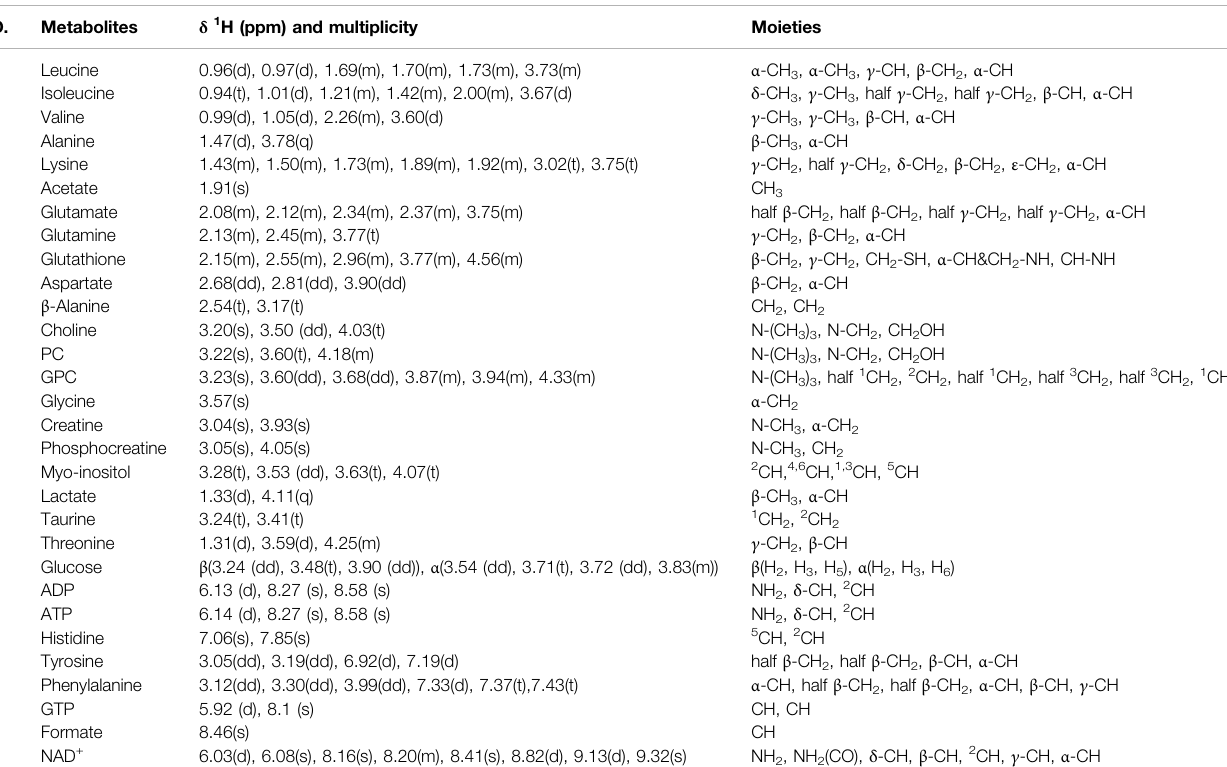
TABLE 1 | Identi fi ed metabolites in 1 H NMR spectra of aqueous extracts derived from C2C12 myoblasts.